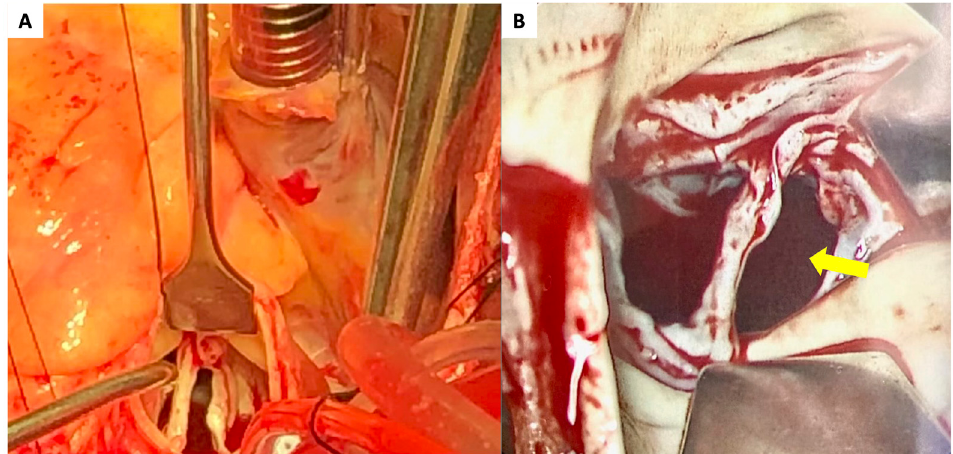
Figure 2. Intraoperative findings of the aortic valve with a wide tear of the RCC. ( A , B ) The yellow arrow indicates the large perforation in the RCC. RCC—right coronary cusp. Following these investigations, this patient was definitively diagnosed with congestive heart failure due to severe AR. Surgical aortic valve replacement with a mechanical valve (29 mm St. Jude) was selected as the treatment. A mechanical valve implant was preferred for this patient due to several factors, includ- ing the patient’s age, tolerance for long-term anticoagulation, the medical reliability of the valve, and risk factors for re-operation. Intra-operatively, a large perforation of the RCC with a string-like